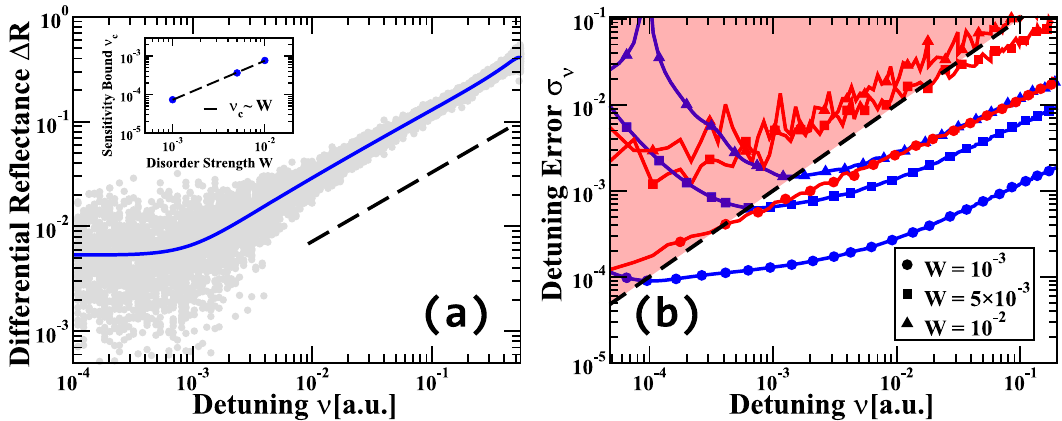
Fig. 4 Effects of disorder in the non-resonant exceptional point degeneracy sensing protocols based on stationary points in the Bloch dispersion relation. a Logarithmic plot of the differential re fl ectance Δ R (gray dots) as a function of the detuning ν from the frequency ω SP for 10 4 disorder realizations of the resonant frequencies of the Coupled Mode Theory model. The disorder strength is taken to be W ¼ 0 : 01. The average value 〈 Δ R 〉 (blue line) follows the predicted dependence Eq. (11) h Δ R i (cid:4) ν j j 0 : 66 indicated by the black dashed line. Inset: The sensitivity bound ν c for three different disorder strengths (blue dots). The black dashed line indicates the best fi t ν (cid:4) W . b Detuning error σ ν as a function of detuning ν for three different disorder strengths in c case of a regular-band-edge-based sensing scheme (red lines) and of a stationary-in fl ection-point-based sensing scheme (blue lines). The red highlighted area represents the domain σ ν > ν where the signal cannot be resolved. The resolution limit for each sensing protocol is de fi ned by the point where the σ ν line crosses the line σ ν ¼ ν ; shown by the black dashed line.